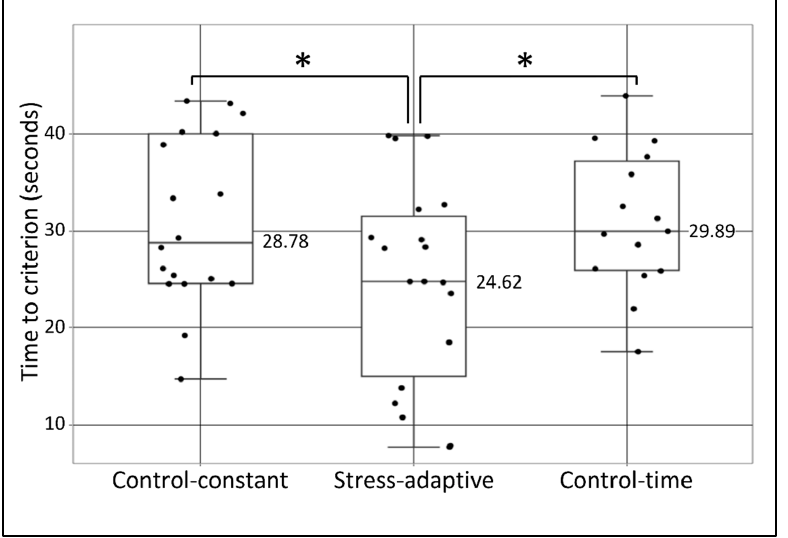
Figure 4. Time to criterion as a function of group. Dots represent the “time to criterion” parameter (from the first derivative cutoff points) for all 52 participants, grouped according to their experimental condition (control-constant, stress-adaptive, and control-time). Boxes represent the inter-quartile range (IQR = Q1 to Q3) of the group, middle horizontal line represents the group’s median, upper line represents the largest value less than upper quartile plus 1.5 times IQR, and the lower line represents the smallest value greater than lower quartile minus 1.5 times IQR. One asterisk represents significance level of p ≤ 0.05.